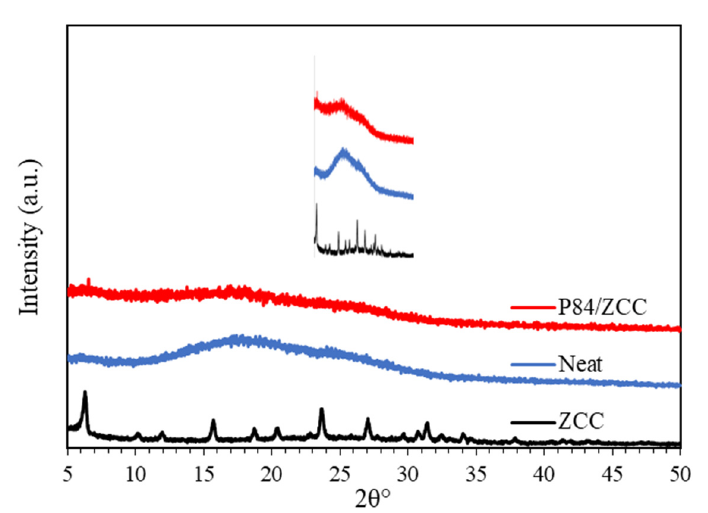
Figure 3. The X-ray diffractograms of prepared membranes.